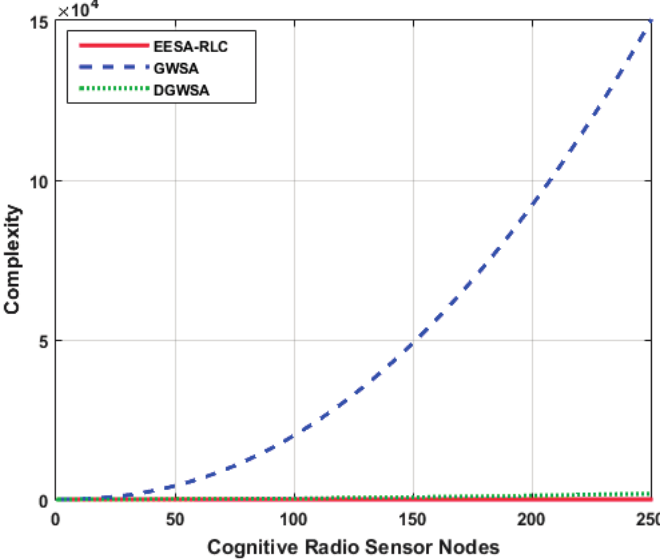
Figure 9. Comparison of computational complexity between EESA-RLC and other